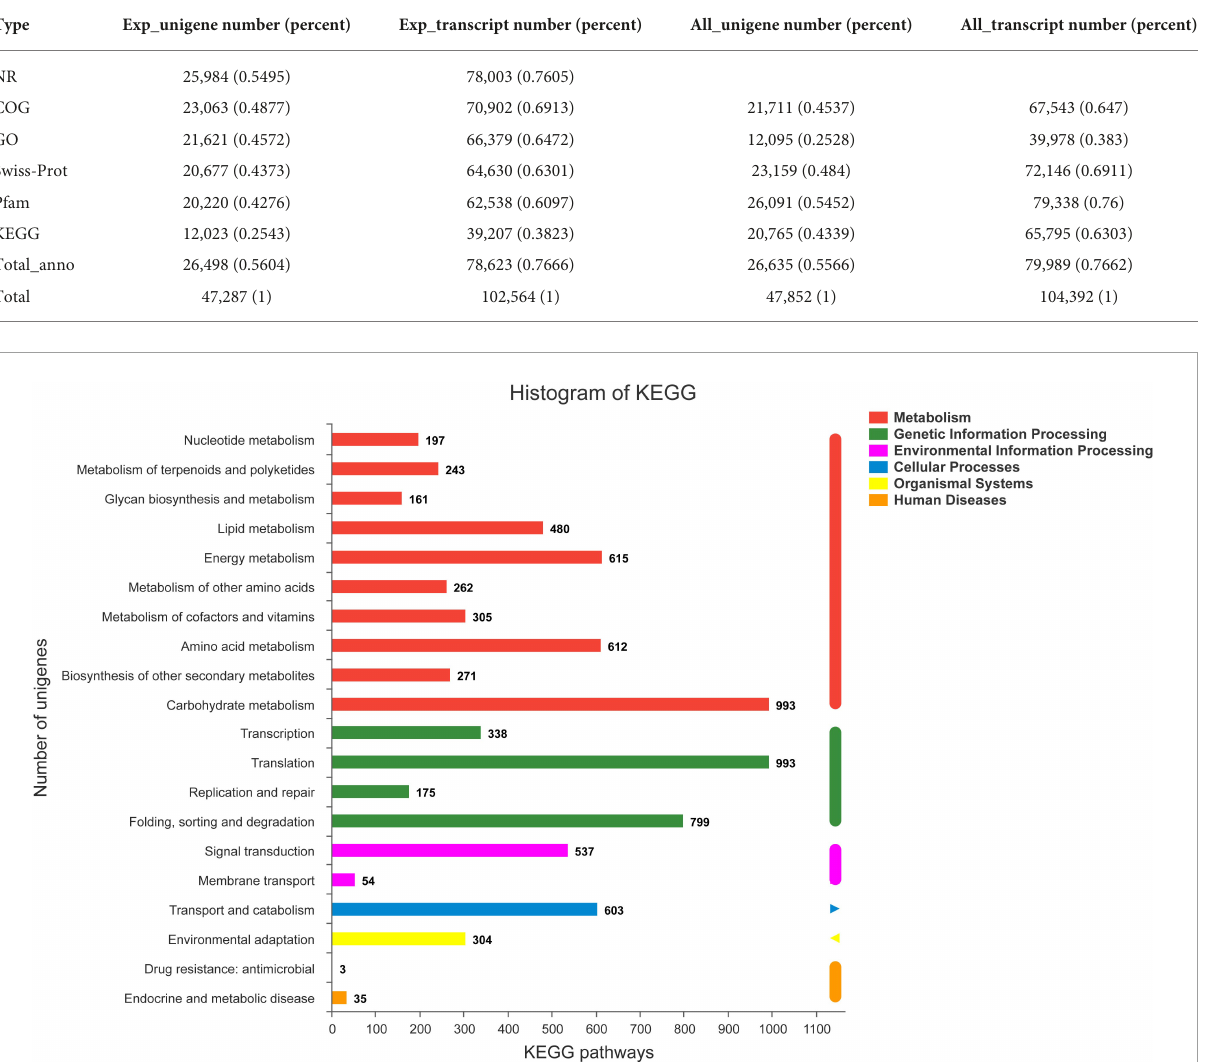
TABLE 3 Statistics of annotation results.